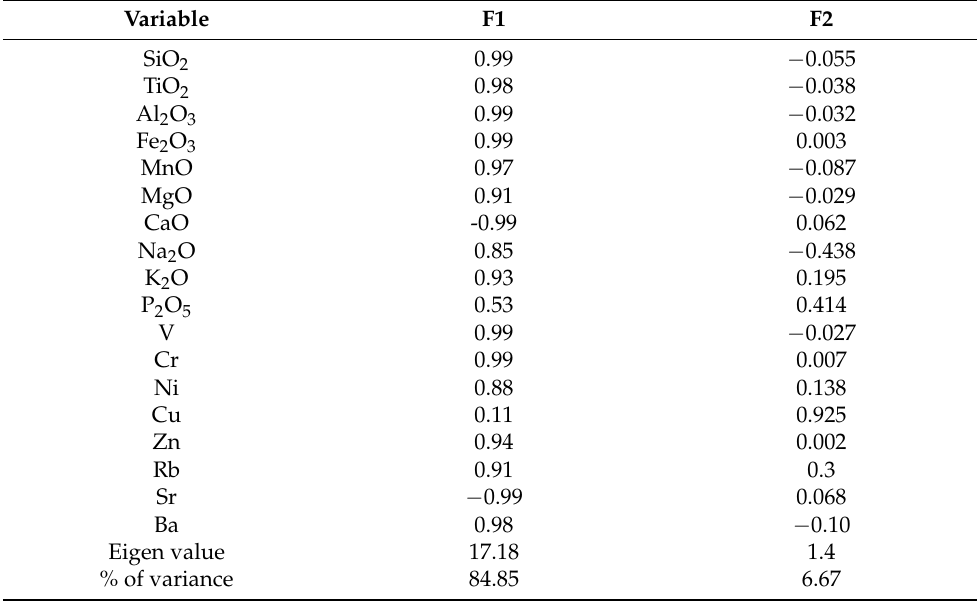
Table 4. Factor loadings of geochemical variables in the bottom sediments of Sharm Al-Kharrar.